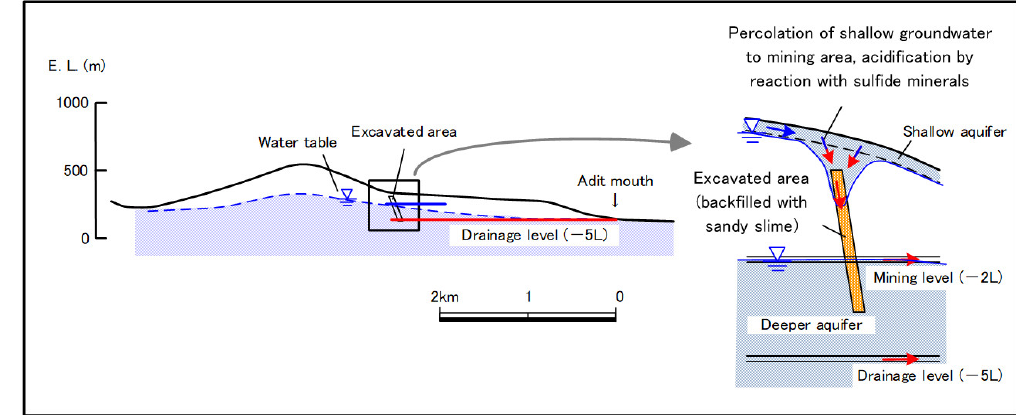
Figure 2. Conceptual model of groundwater flow and its discharge.